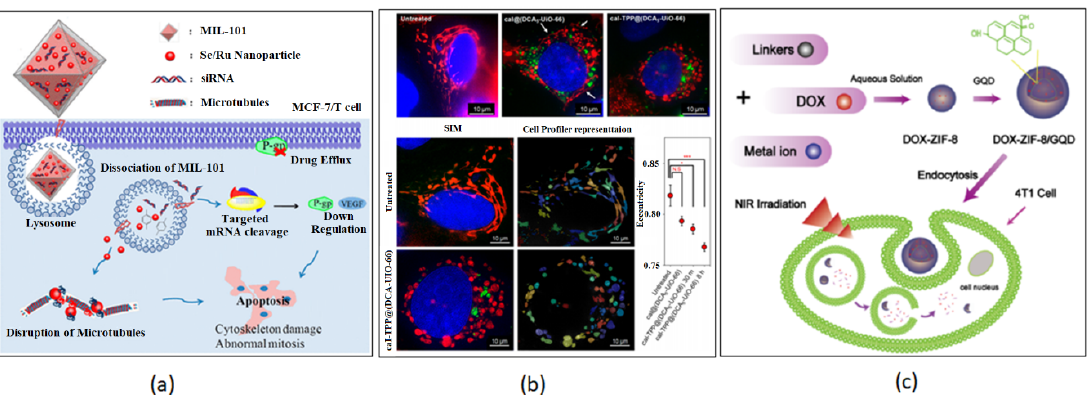
Figure 14. Applications of chemically modified BioMOF nanostructures for Breast Cancer